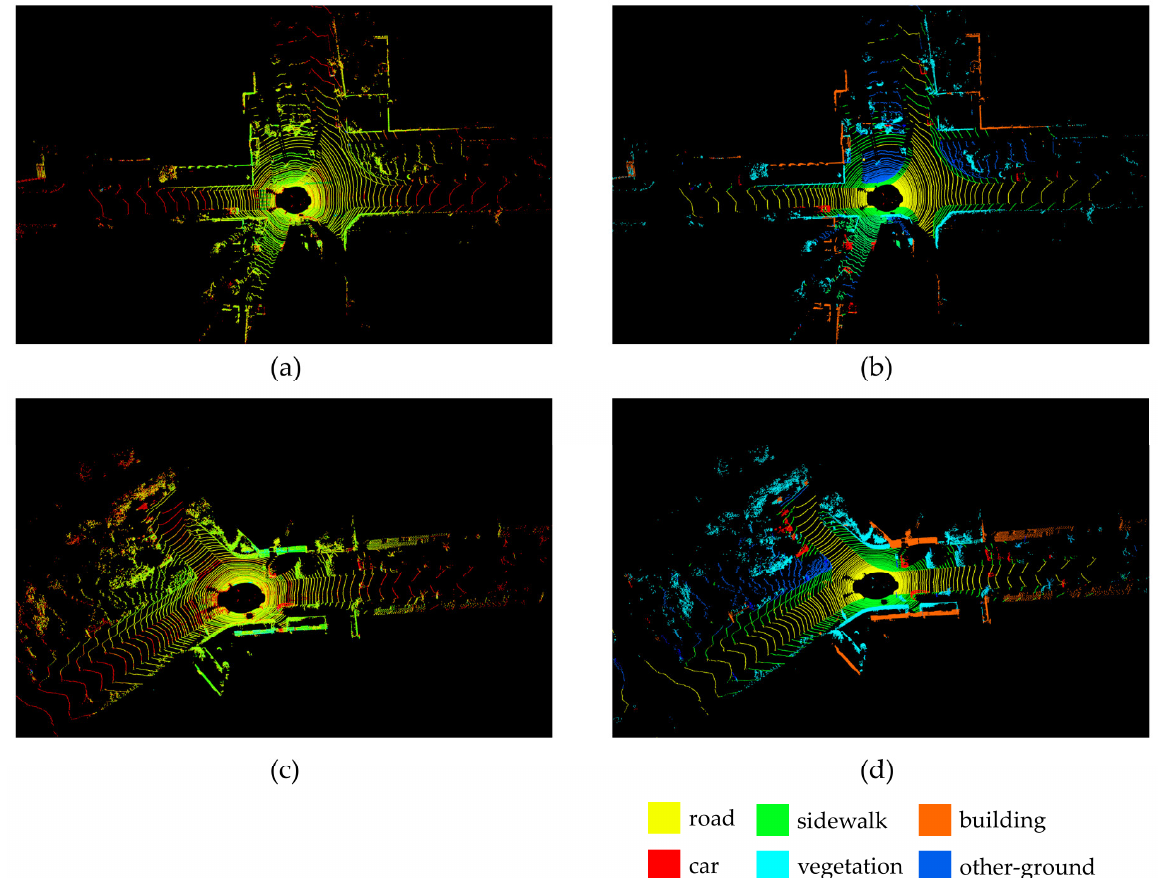
Figure 2. Comparison diagram between original point clouds and semantic point clouds. ( a ) and ( c ) are two frames of raw data captured from KITTI dataset, and the color represents the intensity of the point cloud; ( b ) is the semantic segmentation result of ( a ); ( d ) is the semantic segmentation result of ( c ). In ( c , d ), yellow points mean road, green points mean sidewalk, orange points mean building, red points mean car, light blue points mean vegetation, and blue points mean other